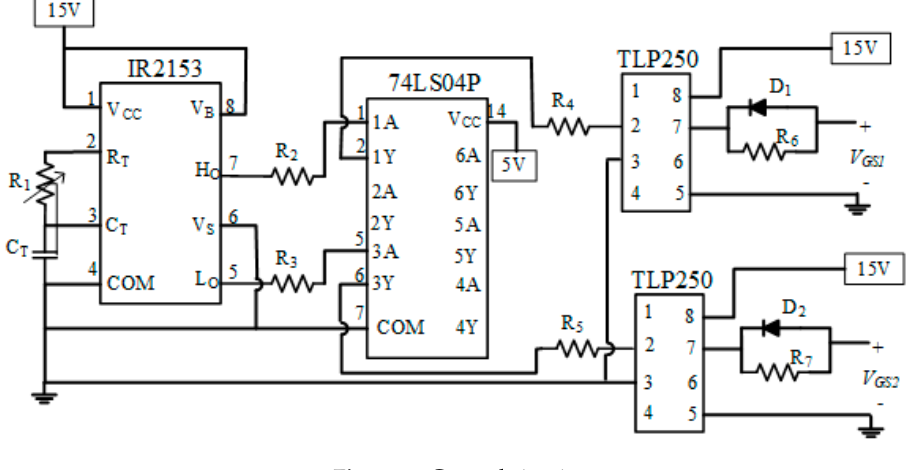
Figure 6. Control circuit.